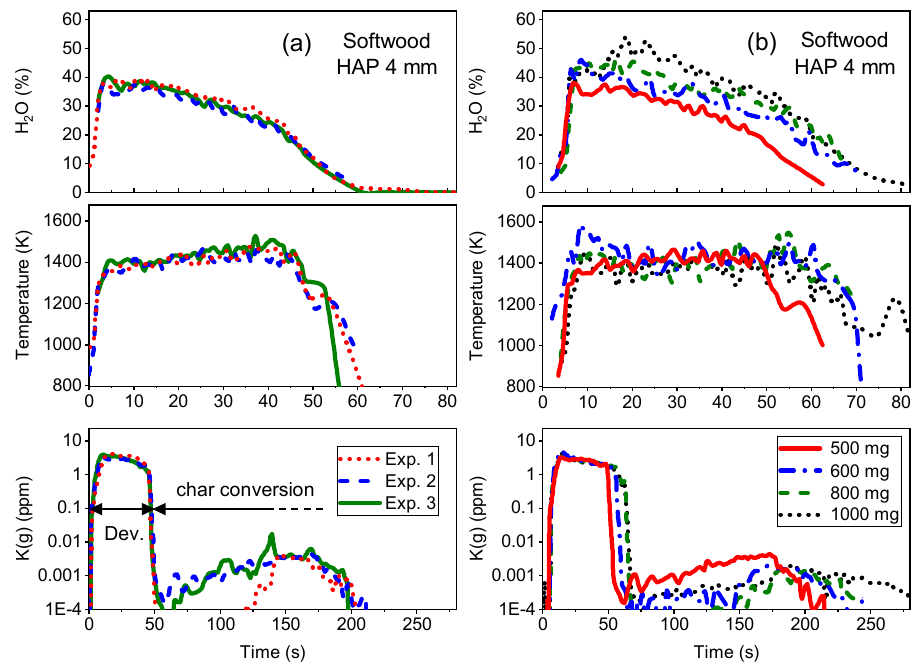
Figure 2. ( a ) Time series of H 2 O, gas temperature and K(g) at HAP 4 mm above softwood particles with initial mass of 500 mg (three replicates). The devolatilization (Dev.) phase (0–50 s) and the char combustion phase (50–250 s) are indicated by arrows. ( b ) Time series of H 2 O, temperature and K(g) at HAP 4 mm above softwood particles with initial masses of 500, 600, 800 and 1000 mg. H 2 O and temperature could be measured only during devolatilization, while the K(g) time series includes the char conversion.